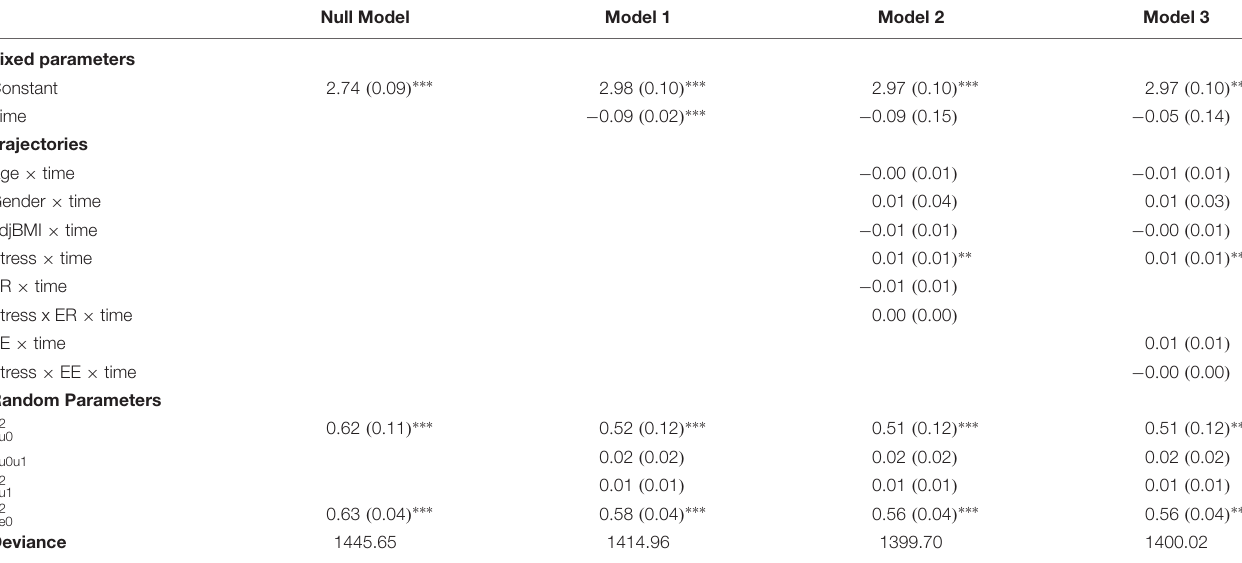
TABLE 4 | Daily hunger eating as a function of stress, maladaptive emotion regulation, and trait emotional